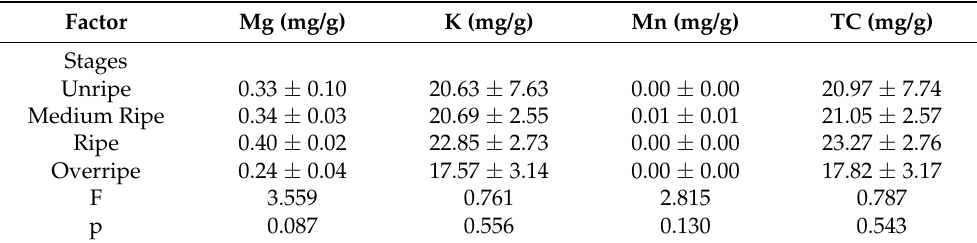
Table 4. ANOVA for magnesium (Mg), potassium (K), manganese (Mn), and total cations (TC) expressed in dry weight and considering the four development stages of H. edulis “ubajay” harvested from the plants growing in Moreno (Buenos Aires). Values represent means ± standard